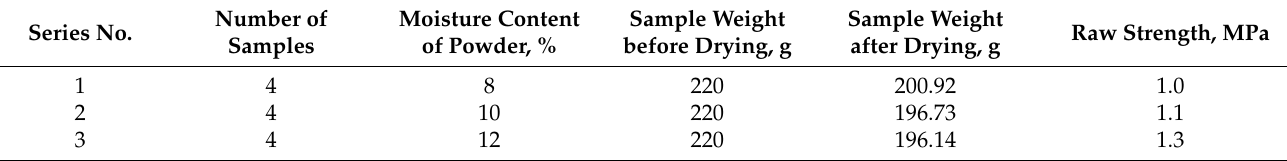
Table 5. Test results for freshly molded samples.